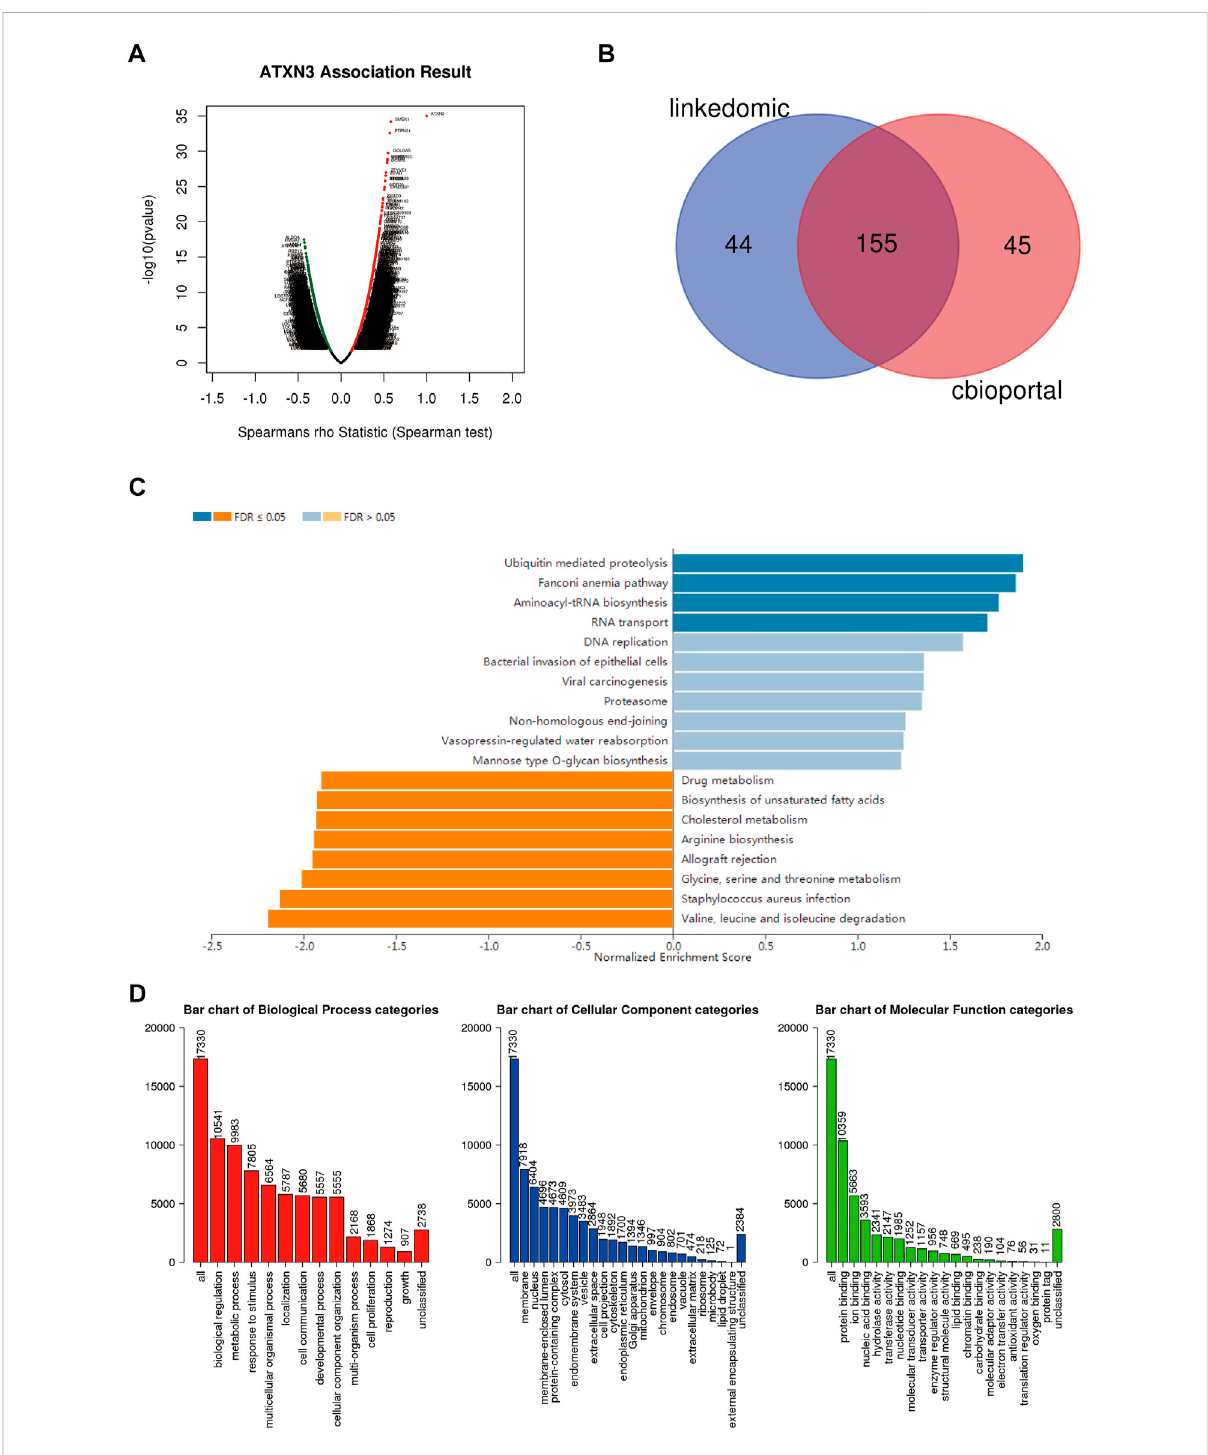
FIGURE 12 Different genes and pathways connected to MJDs family members expression in HCC (A) Volcano plot suggested that the differential expression of genes correlated with ATXN3 in HCC (B) The top 200 co-expressed genes were extracted from the LinkedOmics and cBioPortal, and then the above genes were intersected (C,D) The prediction of GO analysis and KEGG pathway of MJDs family members were